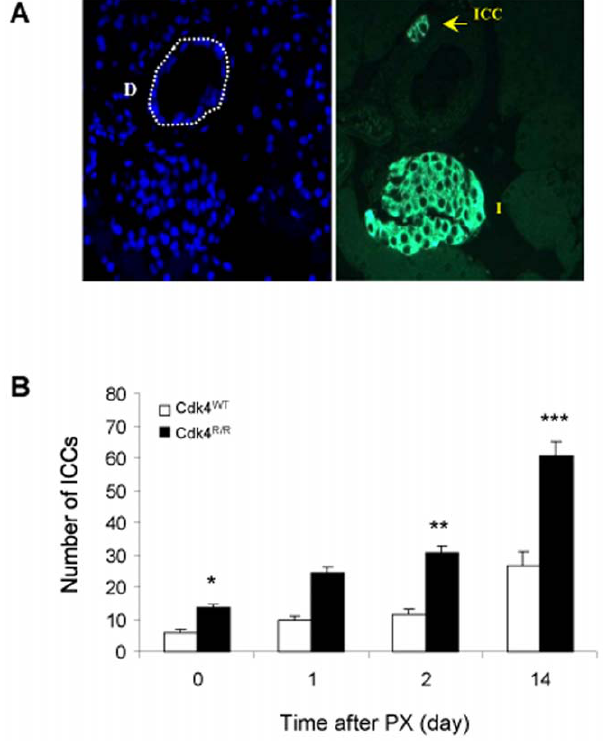
Figure 6. Increased number of islet-like cell clusters (ICCs) in pancreatectomized Cdk4 R/R mice. (A) The number of ICCs that contain 5 or less insulin + cells was counted. Left picture shows DAPI staining and the pancreatic duct (D) is identified by white stippled line. Right picture shows the mature islet (I) and an ICC (yellow arrow) identified upon immunofluorescence staining with insulin antibodies. (B) Number of ICCs was significantly increased before and after PX in Cdk4 R/R mice (closed bars) compared with Cdk4 WT mice (open bars). Values are the results obtained from four mice per group at each time point and expressed as mean number of ICCs per section. Error bars represent S.E. * p , 0.05, ** p , 0.01, and *** p , 0.001 vs Cdk4 WT mice.